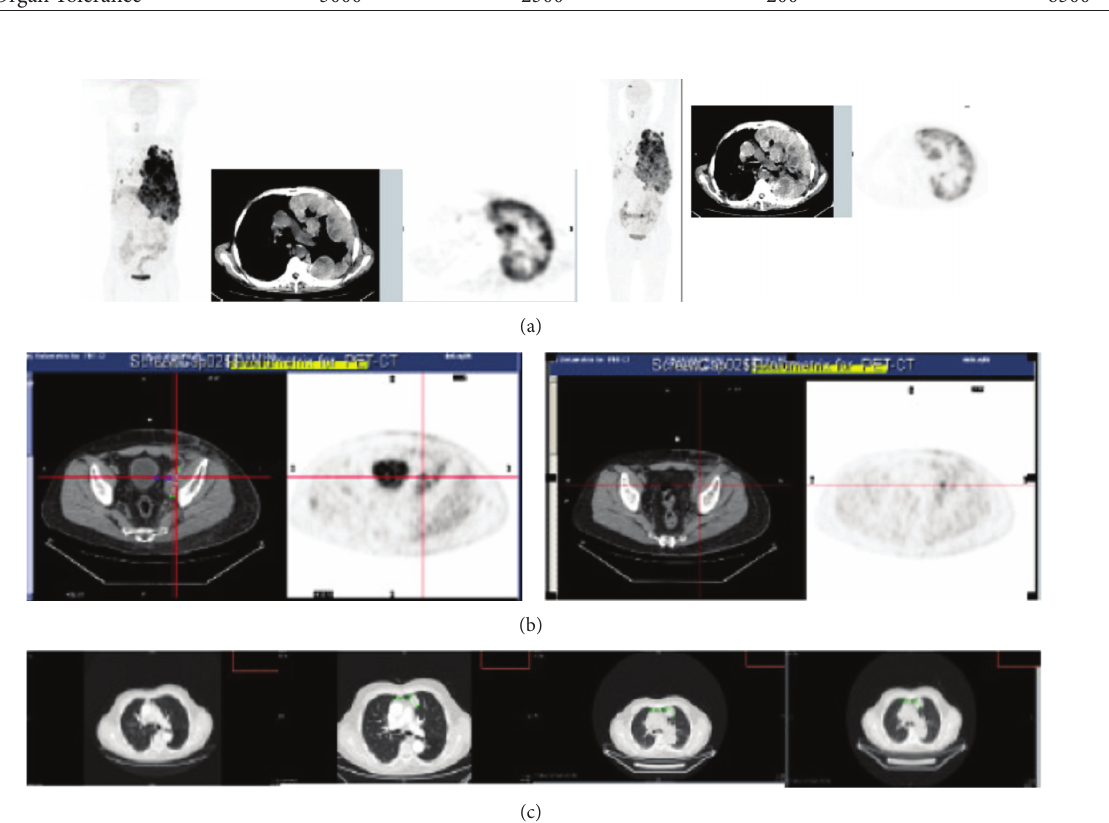
FDG PET/CT of a patient from Phase Ia: le panel—10 days before the study showing coronal and transaxial views, right panel—7 days aer the dose of Re-6D2 mAb; (b) patient from Phase Ib with a stable